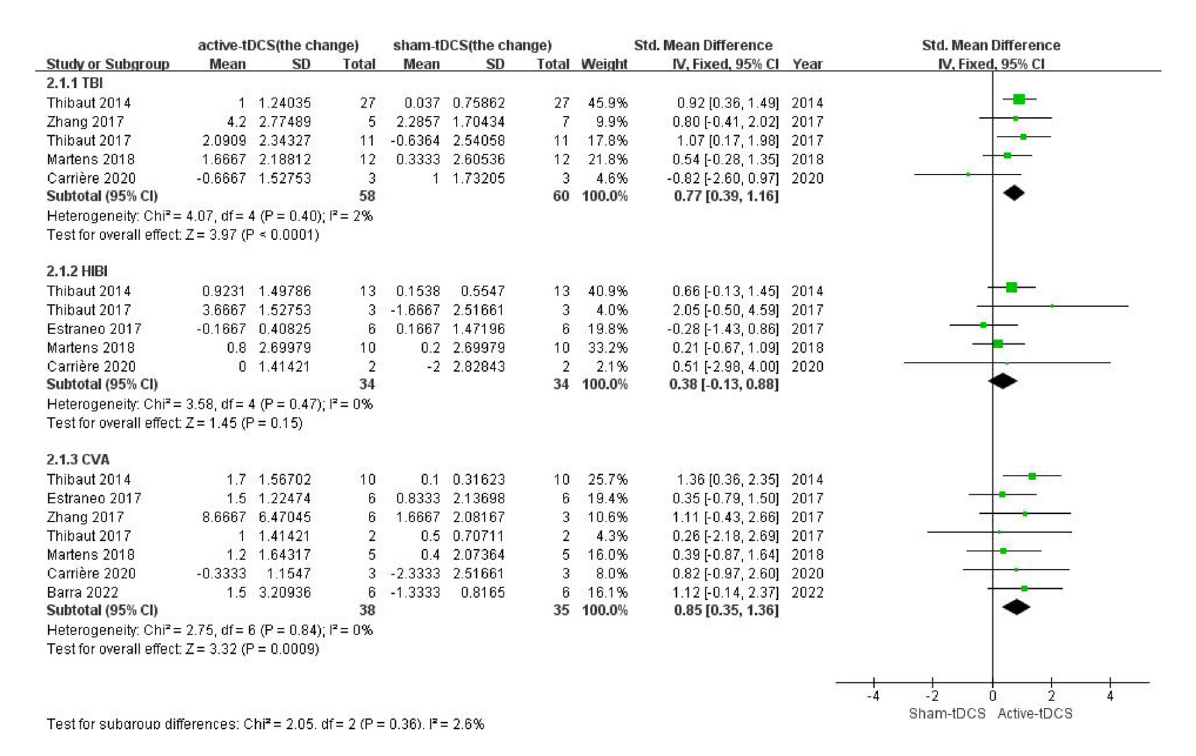
FIGURE5 Subgroup analysis of different clinical